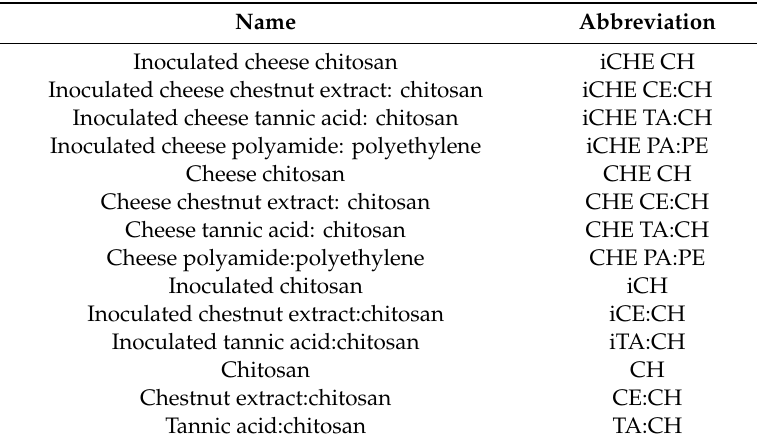
Table 1. Abbreviations used in the